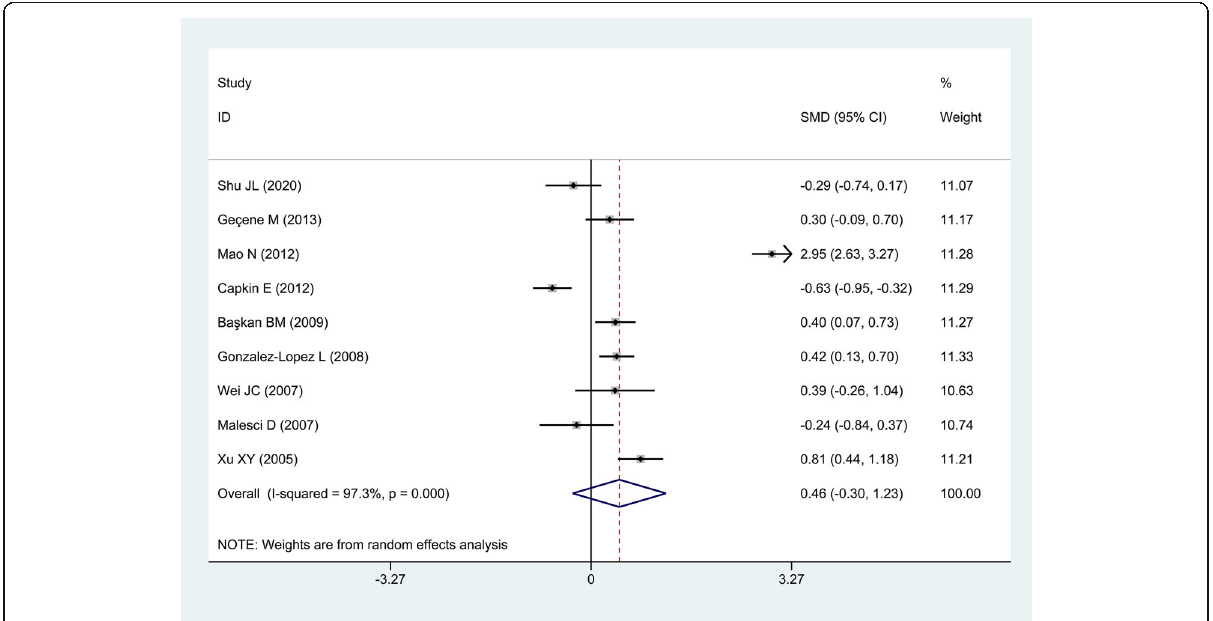
Fig. 3 Forest plot of 9 studies in HCY levels for AS patients versus controls, based on random effects